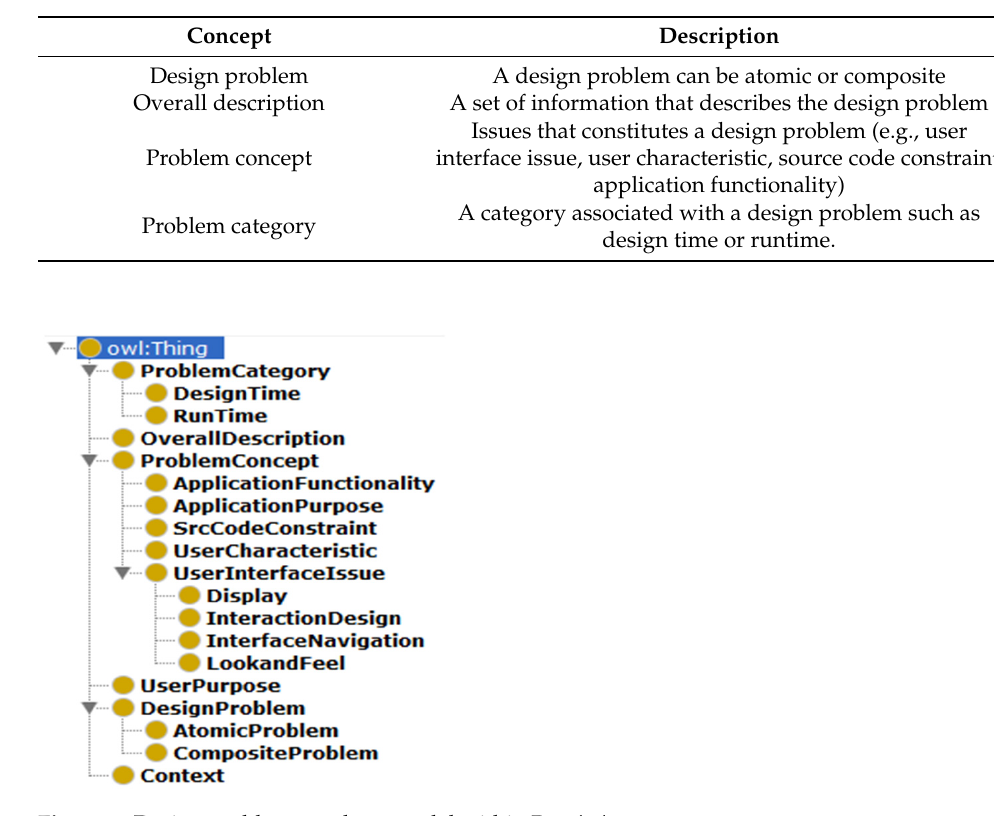
Table 2. Design problem concepts description.